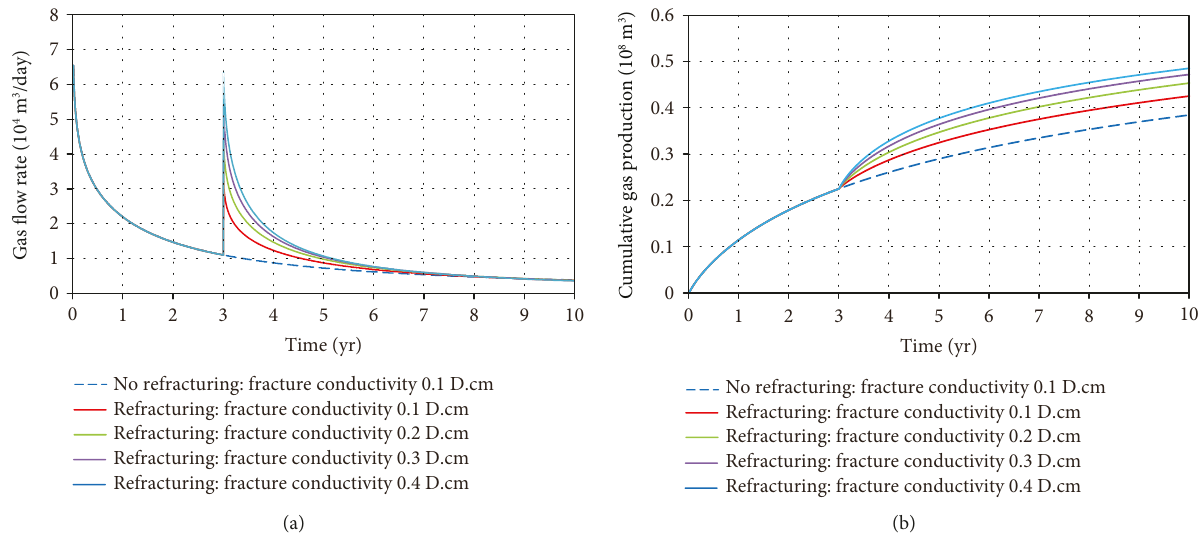
No refracturing: fracture conductivity 0.1 D.cm